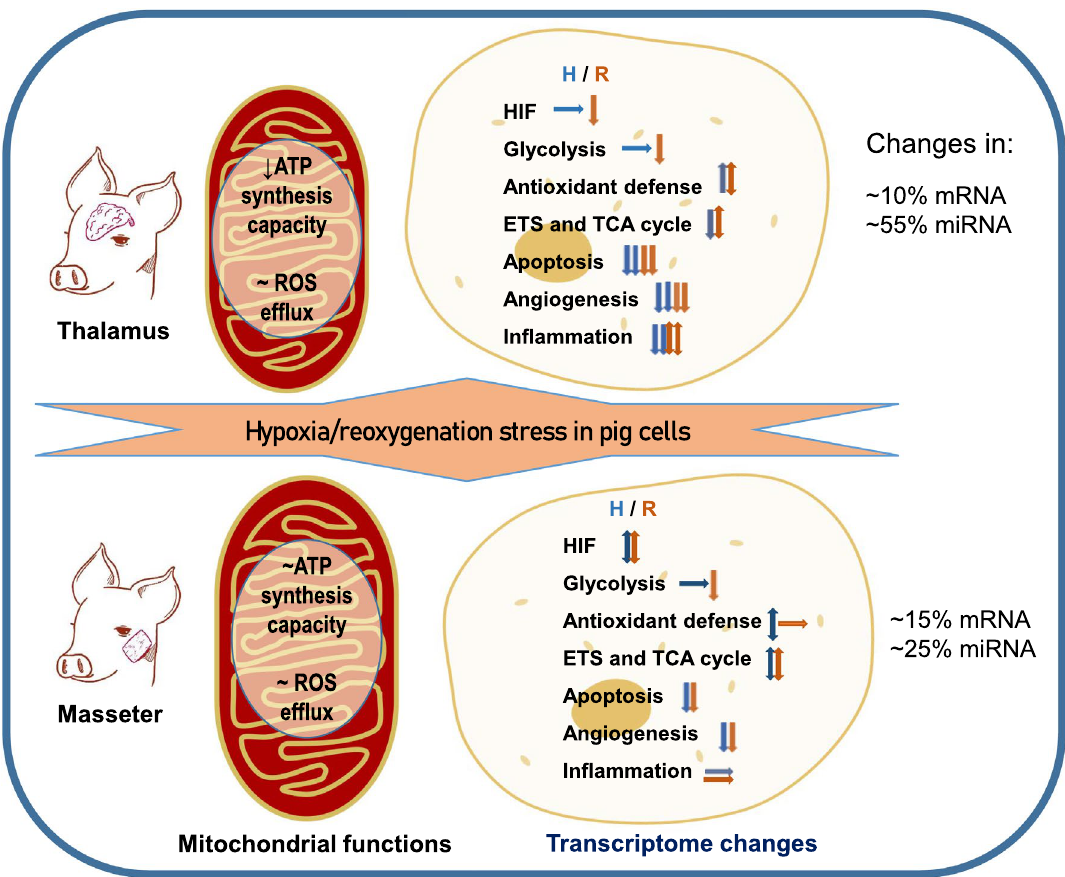
Figure 6. Summary of the observed mitochondrial and transcriptomic changes in response to acute H-R stress in the brain and the muscle cells of the pigs. Mitochondrial functions were assessed only after reoxygenation. mRna and miRNA profiles were measured after hypoxia (blue arrows) and reoxygenation (red arrows). Downward arrows show a decrease, upwards arrows—increase, horizontal arrows—no change. Single arrows— moderate change, double arrows—strong